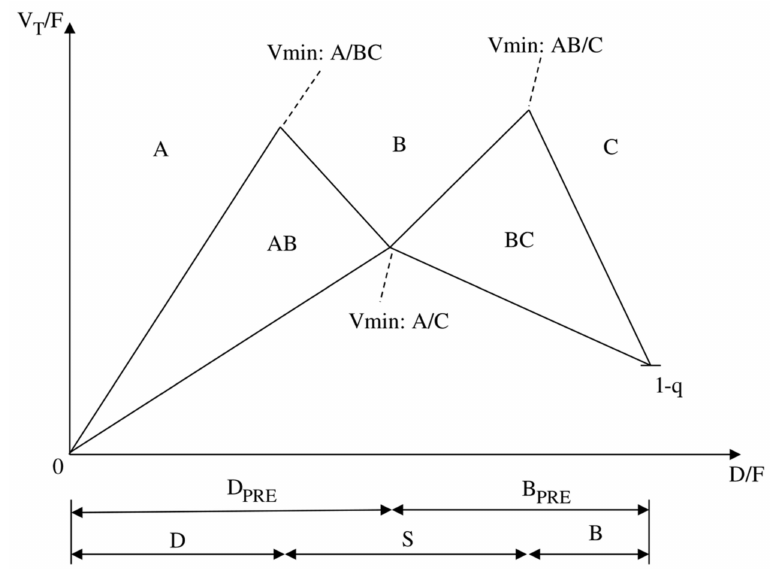
Figure 4. Characteristics of the Vmin diagram for a ternary